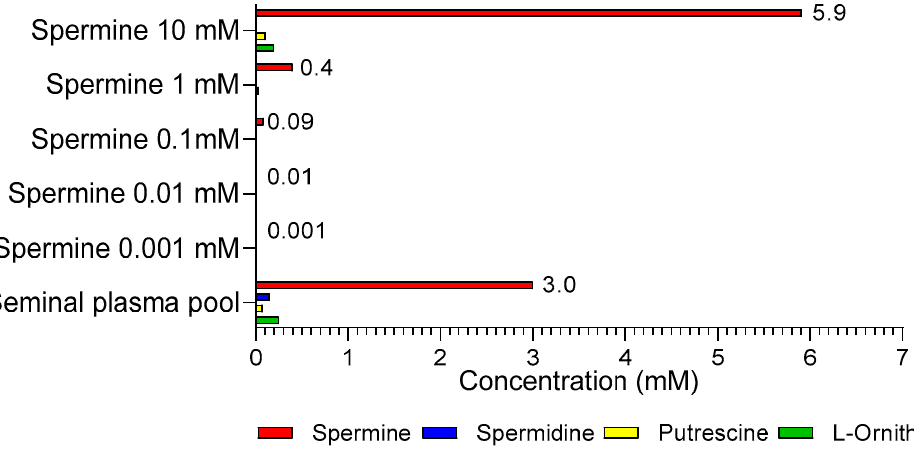
Figure A1. Spermine detection in pooled human seminal plasma. Polyamine concentration was determined in the pooled seminal plasma of 50 individual donors using SPE-LC-MS/MS according to Magnes et al. (2014) [34].